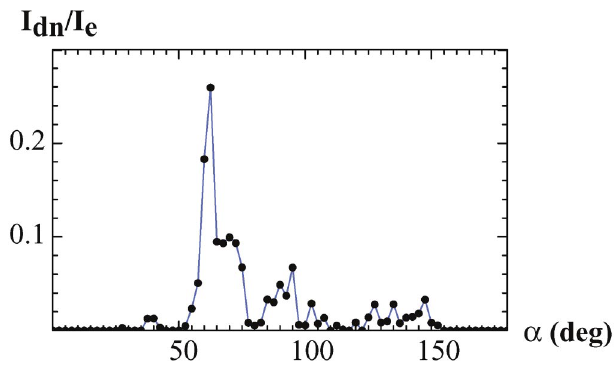
FIG. 5. (Color) Fraction of emitted current that reaches 54 cells downstream of emitting iris vs (cid:17)